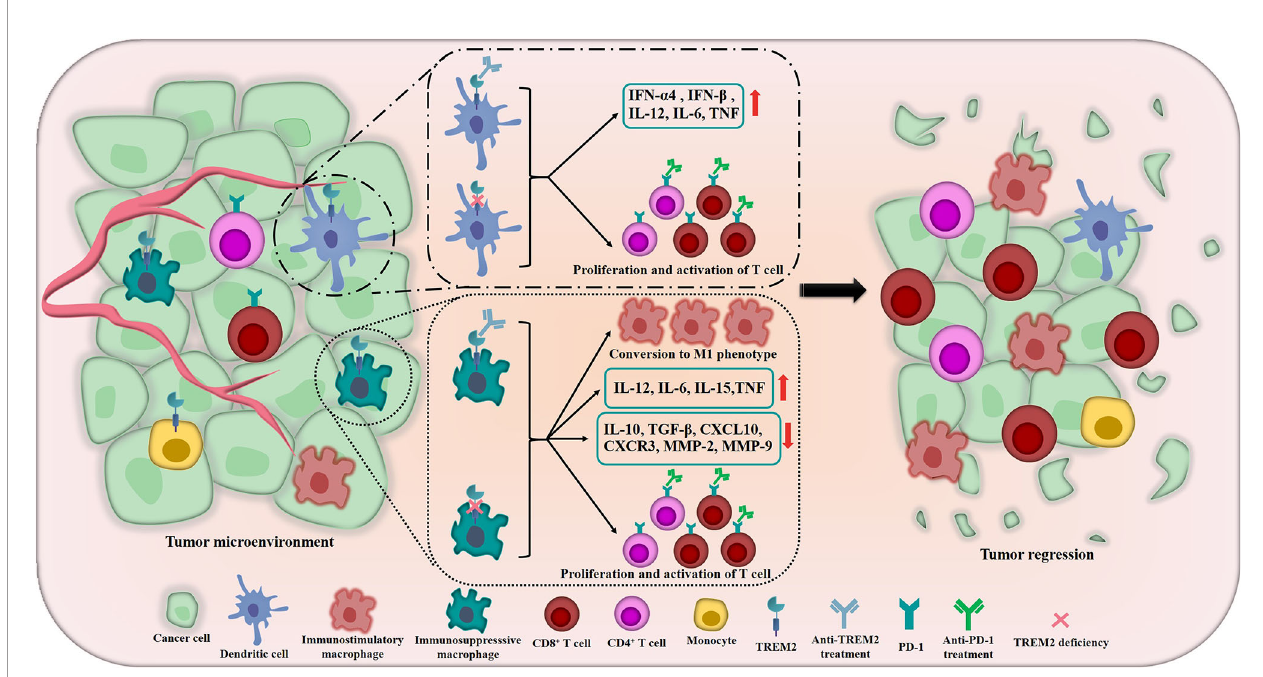
FIGURE 3 | The crucial roles of TREM2 in remodeling TME and inhibiting tumors. In TME, the tumor suppressor TREM2 is highly expressed in some myeloid cells including DCs, immunosuppressive macrophages, monocytes, etc. The inhibition of TREM2 could induce DCs produce increased type I IFN (including IFN- a 4 and IFN- b ), IL-12, IL-6 and TNF. In terms of regulating macrophages, TREM2 de fi ciency and anti-TREM2 mAb could promote the phenotypic conversion of macrophages to M1 phenotype which have anti-tumor function, meanwhile, the secretion of IL-12, IL-6, IL-15 and TNF are signi fi cantly induced and the levels of IL-10, TGF- b , CXCL10, CXCR3, MMP-2 and MMP-9 are decreased. More importantly, TREM2 de fi ciency and anti-TREM2 mAb also noteworthily promote the proliferation and activation of CD8 + T cells and CD4 + T cells which expressed PD-1 and potentially improve the responsiveness of cancers to anti-PD-1 treatments. The above crucial roles of TREM2 meaningfully remodel the TME and ultimately promote tumor regression and improve the therapeutic effect of